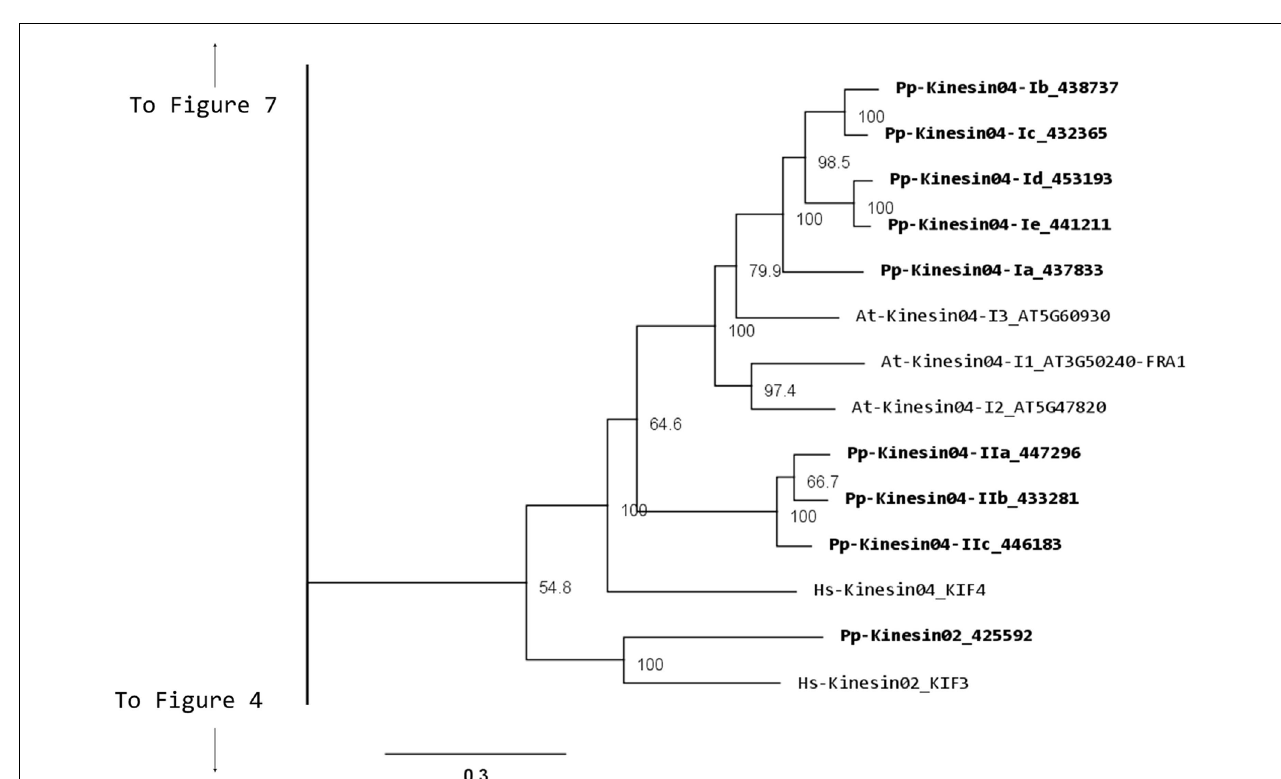
the nodes show the statistical support of values above 50%.The scale shows the estimated branch length corresponding to the number of substitutions per site.The Physcomitrella numbers correspond to the Phypa number uniquely associated with each gene model (version 1.6) at